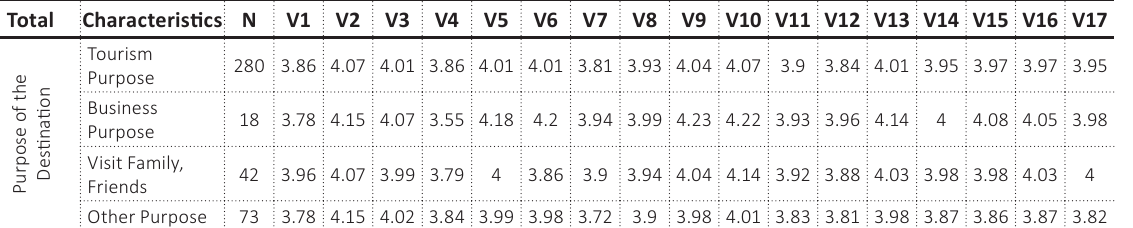
Table 9 (cont.). ANOVA and T-test results –